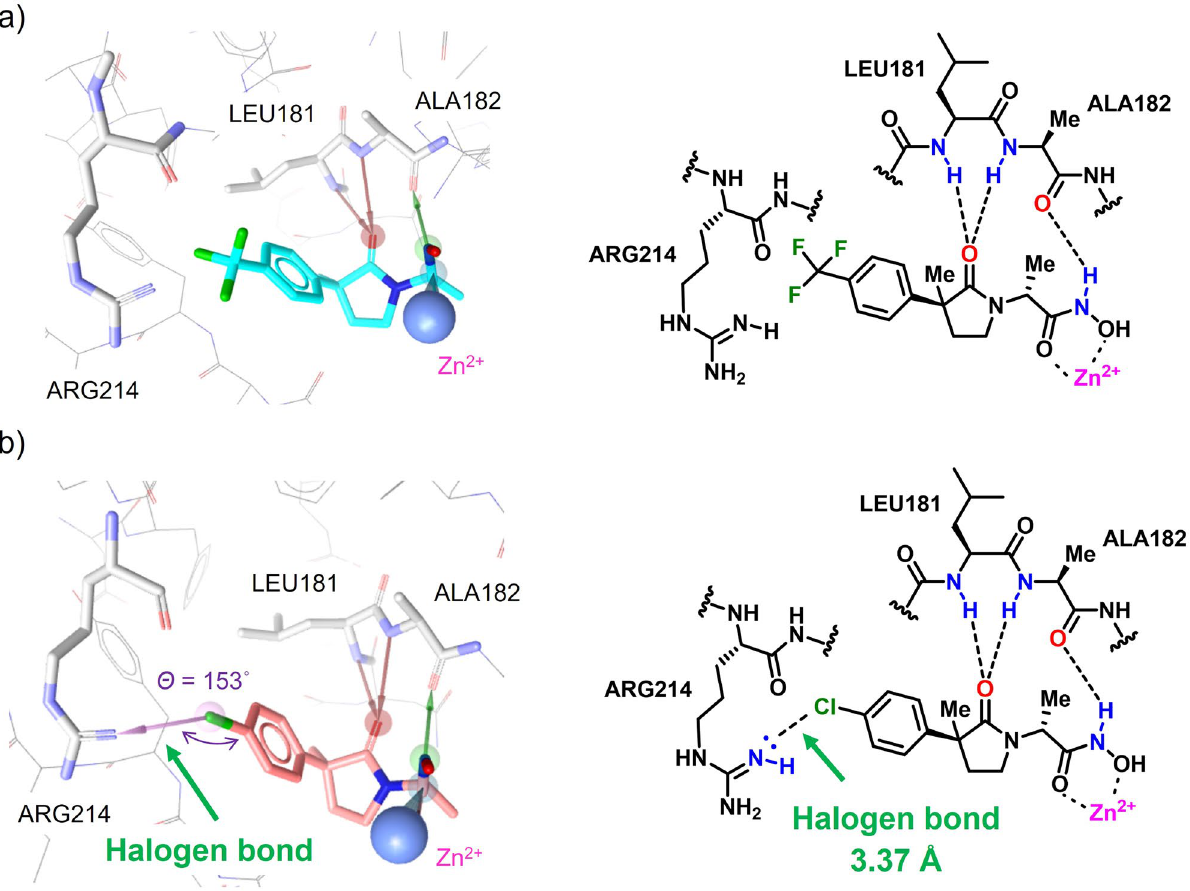
Figure 4. Pharmacophore fitting of compound ( a ) 4 and ( b ) 6 to the SC44463 pharmacophore model constructed from the crystal structure of compound SC44463 in complex with MMP-1 (PDB entry 1FBL) 19